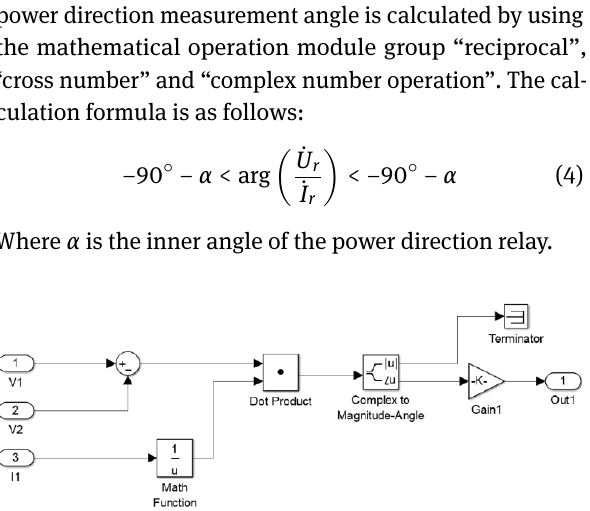
Figure 7: “90 ∘ wiring” component model